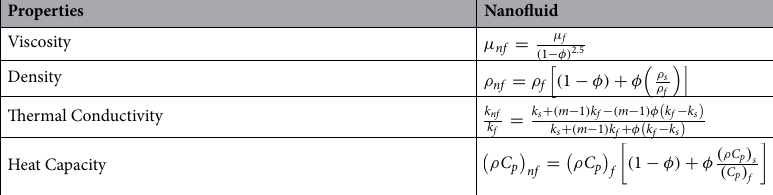
Table 1. Thermophysical characteristics of nanofluid (Iqbal et al. 43 ). Here, ( m ) is the shape